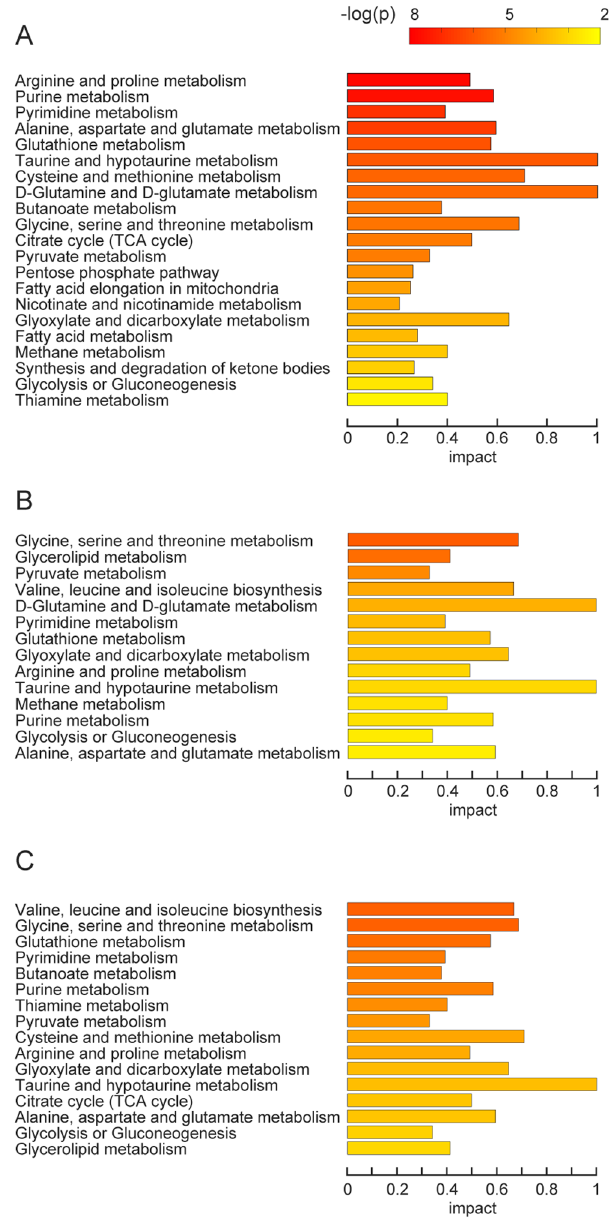
Figure 4. Metabolic pathways affected by cold exposure in adipose tissues from different depots. Combined pathway enrichment and pathway topology analyses were performed based on the changing polar metabolic profiles in BAT ( A ), SWAT ( B ) and VWAT ( C ) during cold exposure. Bar colors reflect the significance (p value) for the specific pathway. The length of each bar indicates the impact value of each metabolic pathway. Pathways with p < 0.01, FDR < 0.01, impact > 0.2 are